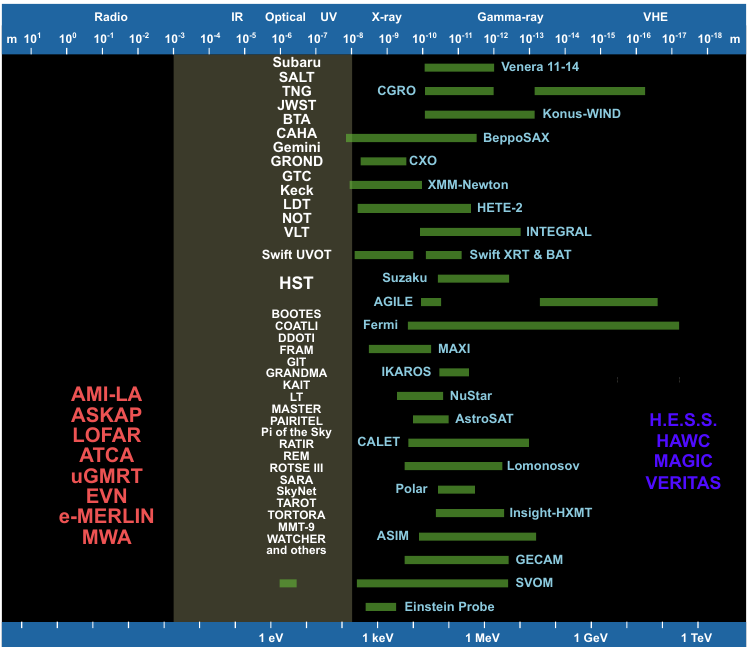
Figure 6. GRBs are detected across the whole electromagnetic spectrum. Some of the ground- and space-based facilities that observe GRBs are shown in this